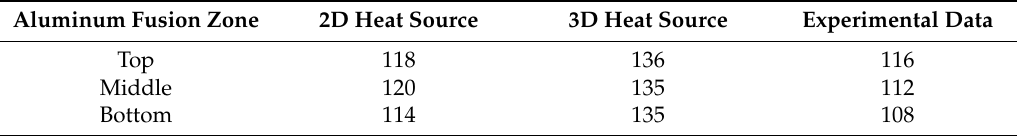
Table 5. Dimension (mm) of the fusion zone profile in the aluminum side.